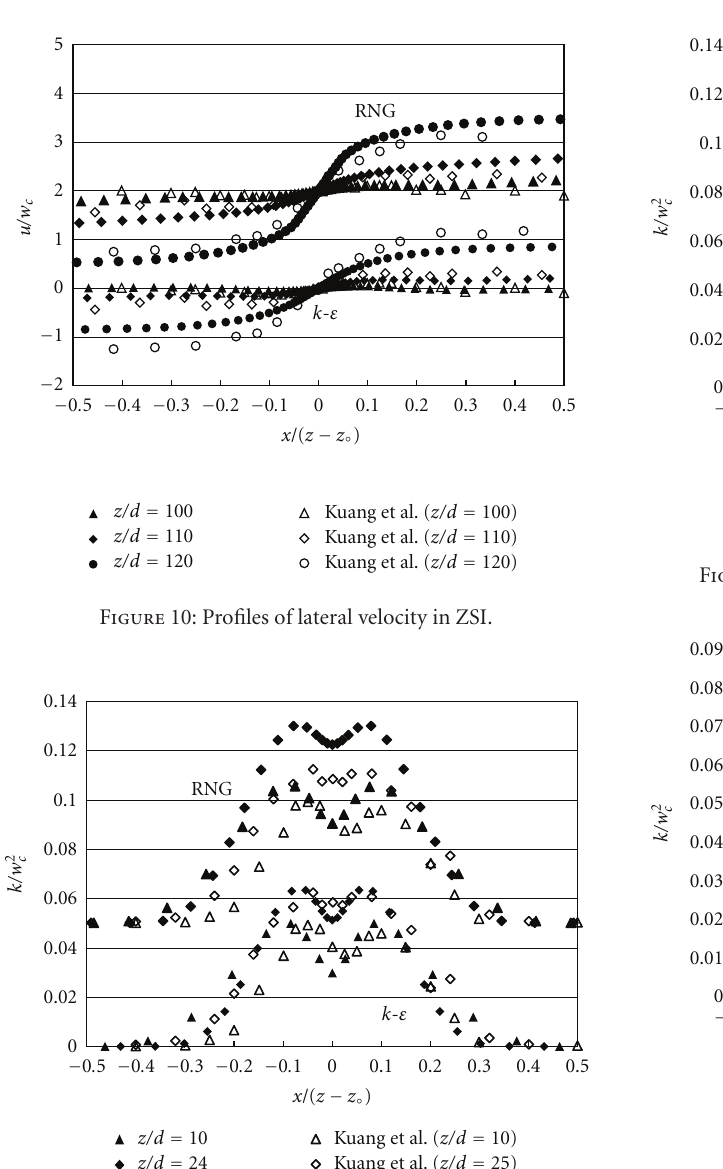
shown in Figures 14 and 15, respectively. Both schemes predict maximum velocity at the surface and similarity of the velocity profiles in the positive flow region. The results obtained using the k - ε scheme show a better agreement with the measured data and a Gaussian fit. Kuang at al. [7] provided a Gaussian fit for approximating the measured data in the positive flow region and is given by where u m is the maximum lateral velocity. The recirculation zone underneath the surface jets is poorly resolved by the RNG scheme and may be the results of high growth